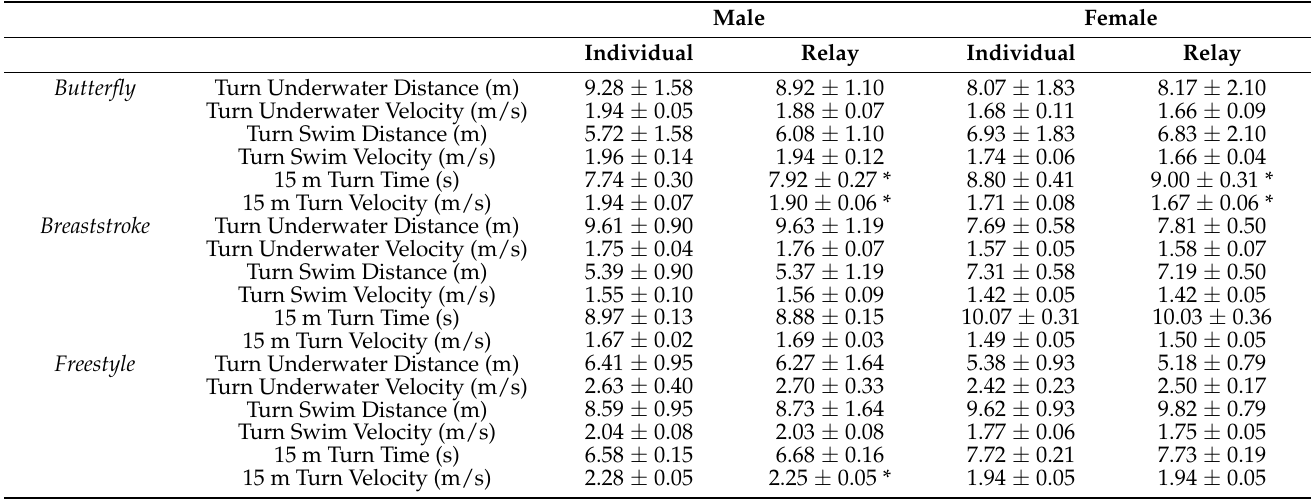
Table 2. Comparisons of turn parameters between individual and relay events in the LEN European Junior Swimming Championships.